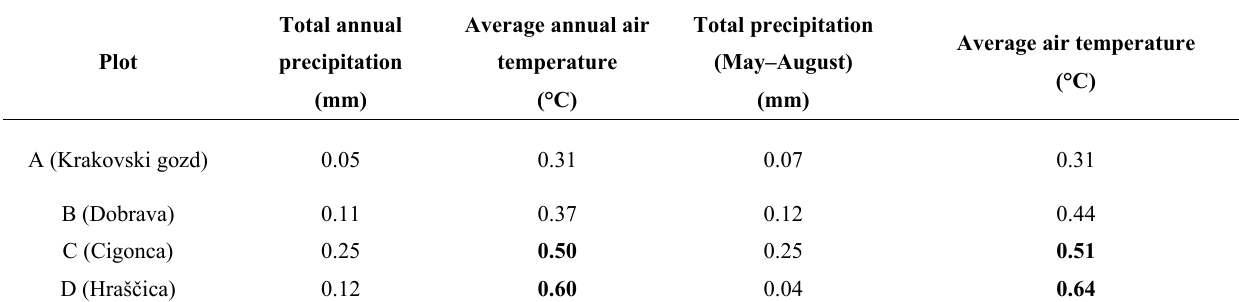
Table 4. Correlation coefficients ( r 2 ) between mortality vs. total precipitation and average air temperatures in different periods (1995–2013). Values higher than r 2 = 50 are marked in